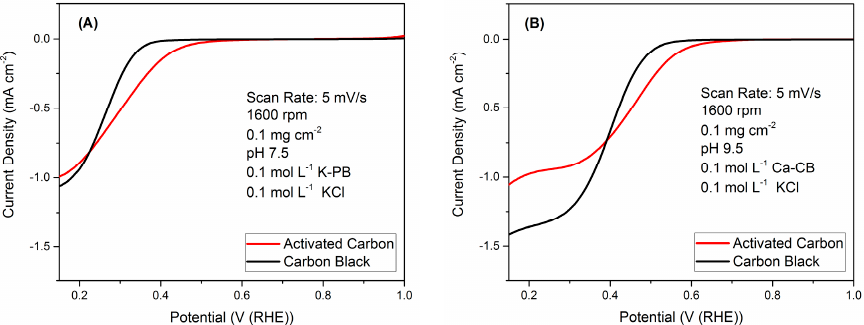
Figure 1. Polarization curve of activated carbon and carbon black, rotation speed of 1600 RPM with pH 7.5 ( A ) and pH 9.5 ( B ) with an oxygen ‐ saturated